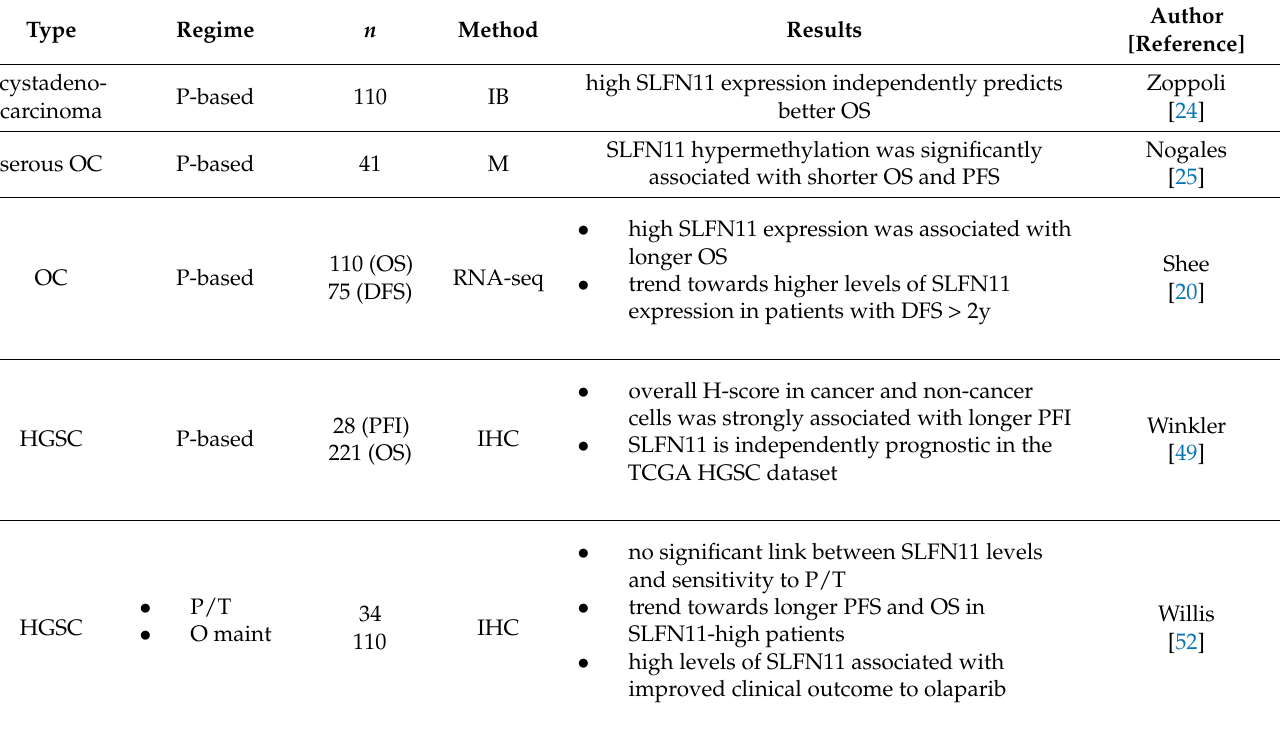
Table 3. Summary of studies evaluating the prognostic or predictive role of SLFN11 in ovarian cancer patients treated with platinum (P)-based chemotherapy or